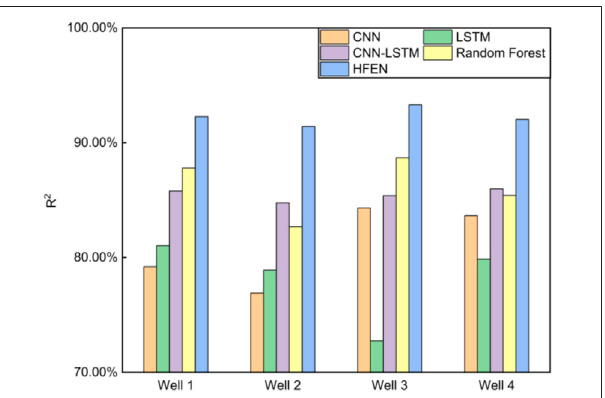
FIGURE 15 | Comparison of predicted results (RMSE) between HFEN and other networks: CNN, LSTM, base CNN-LSTM, and random forest.